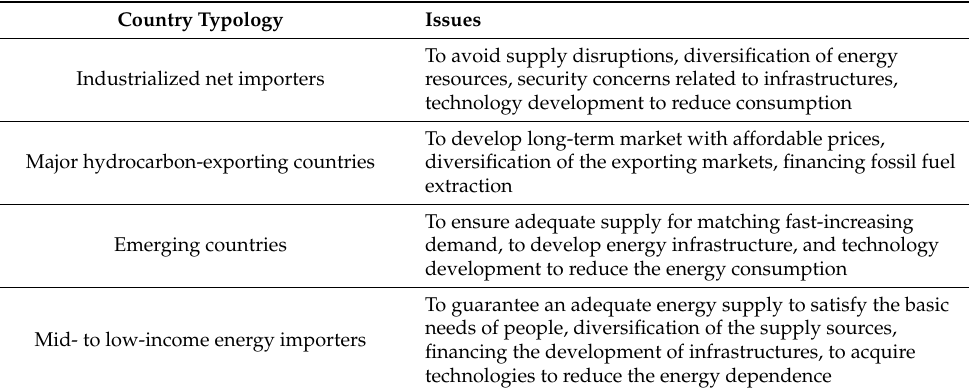
Table 1. Main issues of energy security based on the country’s typology